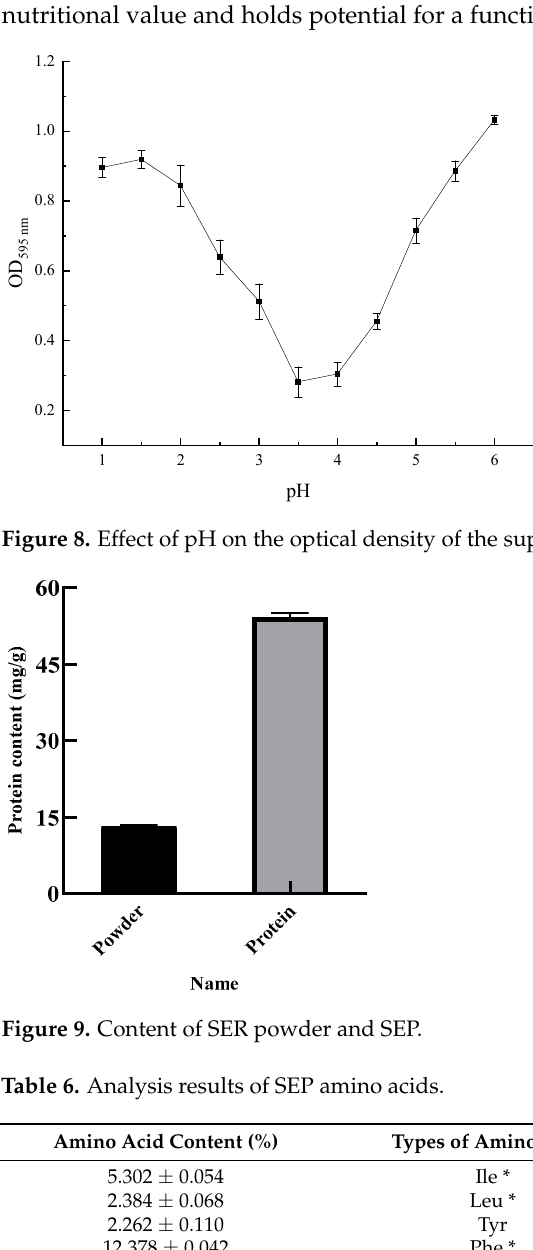
Figure 9. Content of SER powder and SEP.